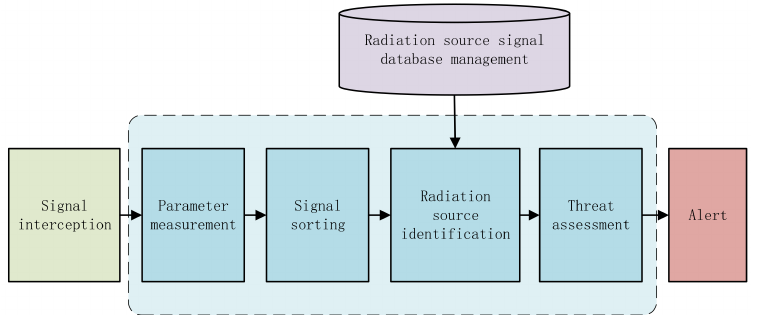
Figure 1. Radar warning device data processing